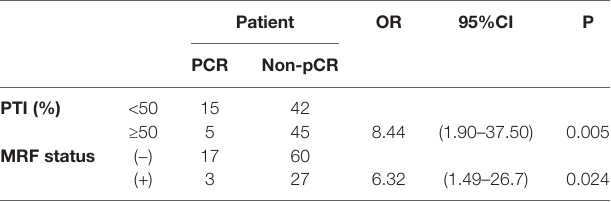
TABLE 3 | Univariate Analysis in Factors In fl uencing pCR of T3 Rectal Cancer. TABLE 4 | Multivariate Analysis in Factors In fl uencing pCR of T3 Rectal